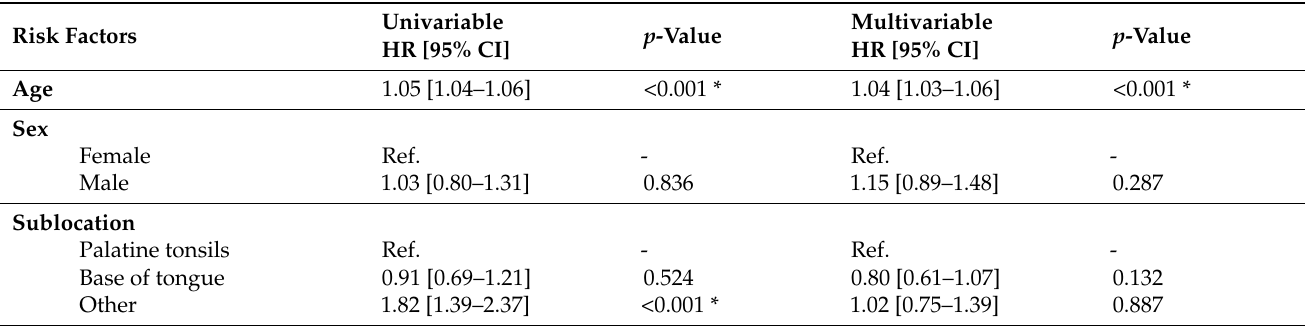
Table 2. Univariable and multivariable analysis of possible risk factors for